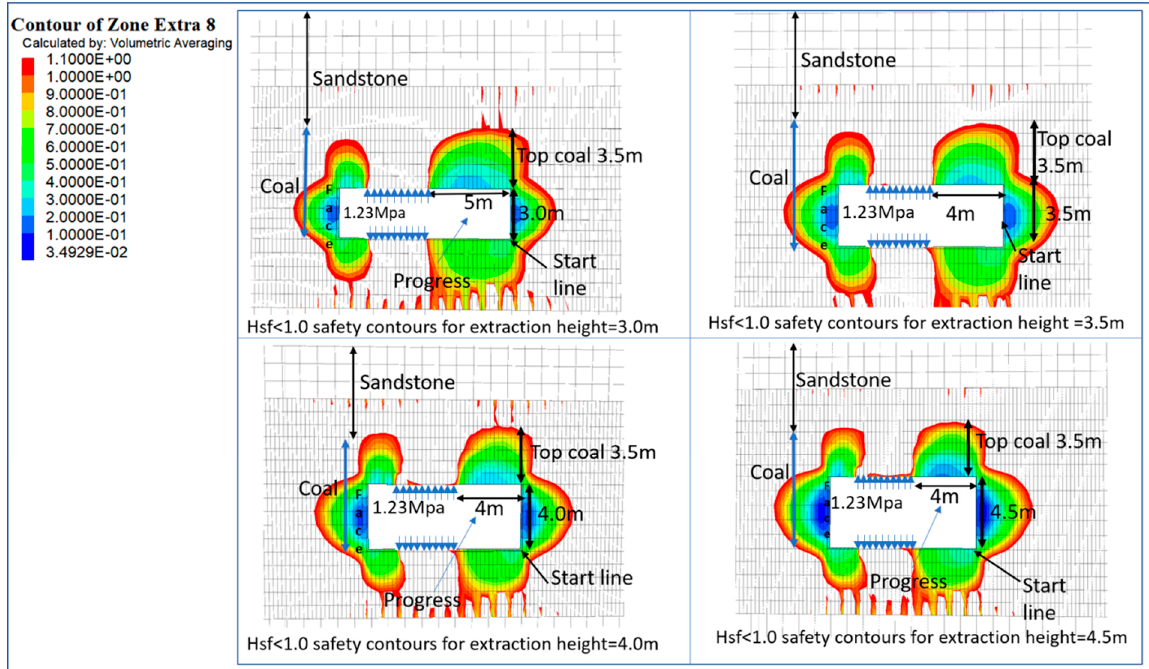
Figure 6. Modeling for different extraction height values.